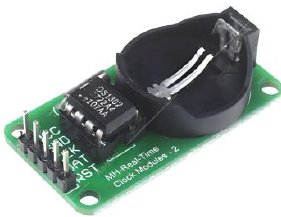
Figure 5. DS1302 Real Time Clock Module [23].